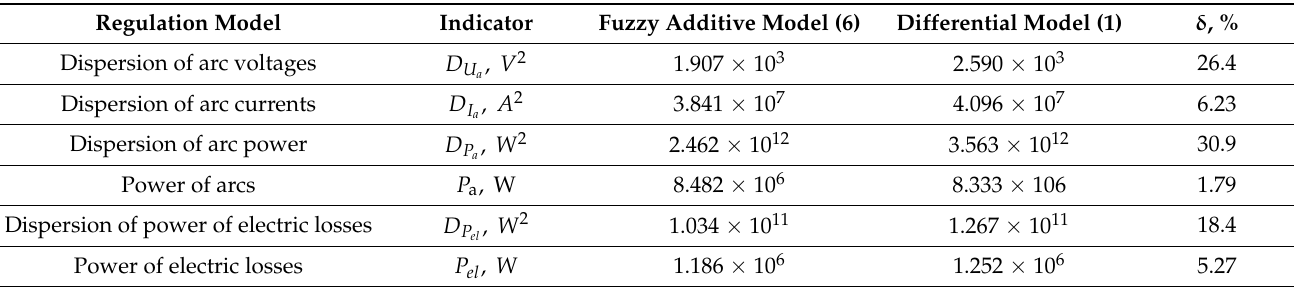
Table 2. Indicators of dynamics quality and energy efficiency of random perturbations control at the first technological stage of melting.